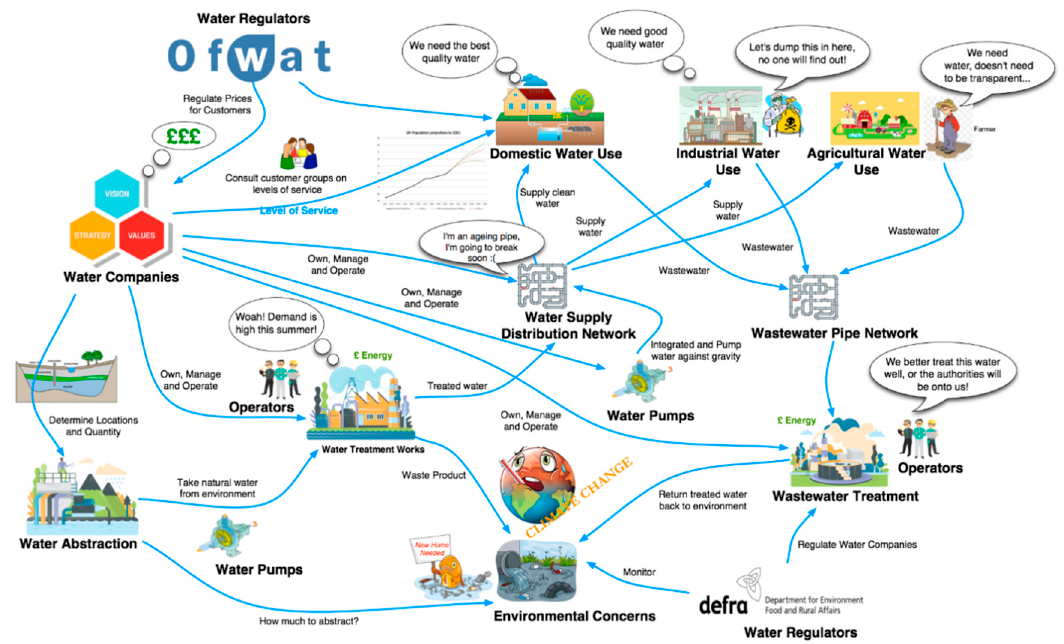
Figure 1. Rich picture of UK water sector.